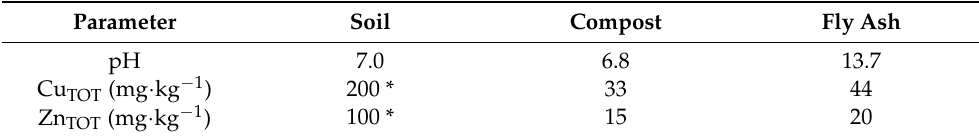
Table 1. Basis properties of soil, compost and fly ash (data for composite samples). Parameter Soil Compost Fly Ash pH 7.0 6.8